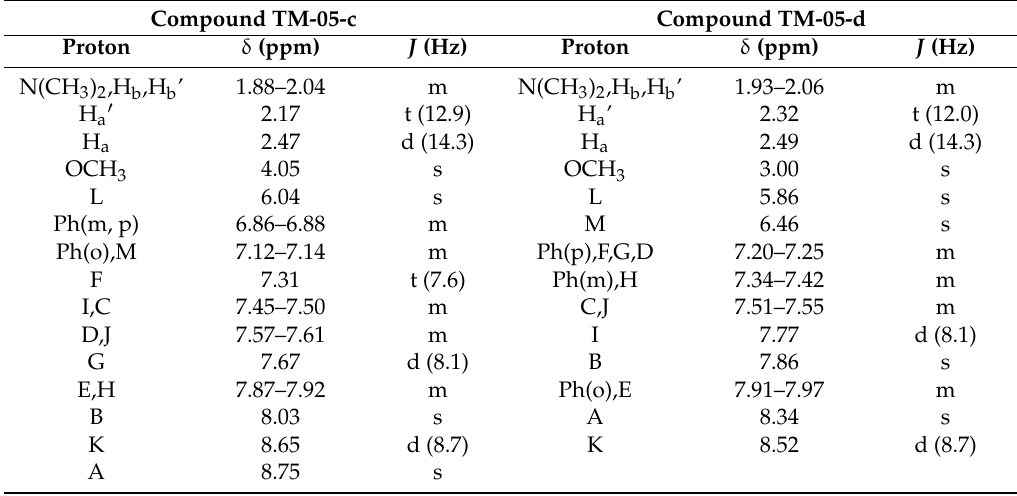
Table 1. Proton chemical shifts and coupling constants in CDCl 3 of TM-05-c and